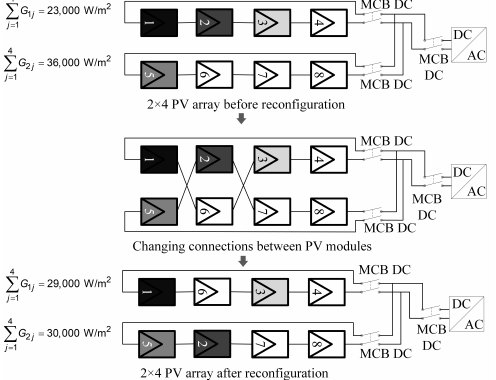
Figure 2. Principle of irradiance equalization of